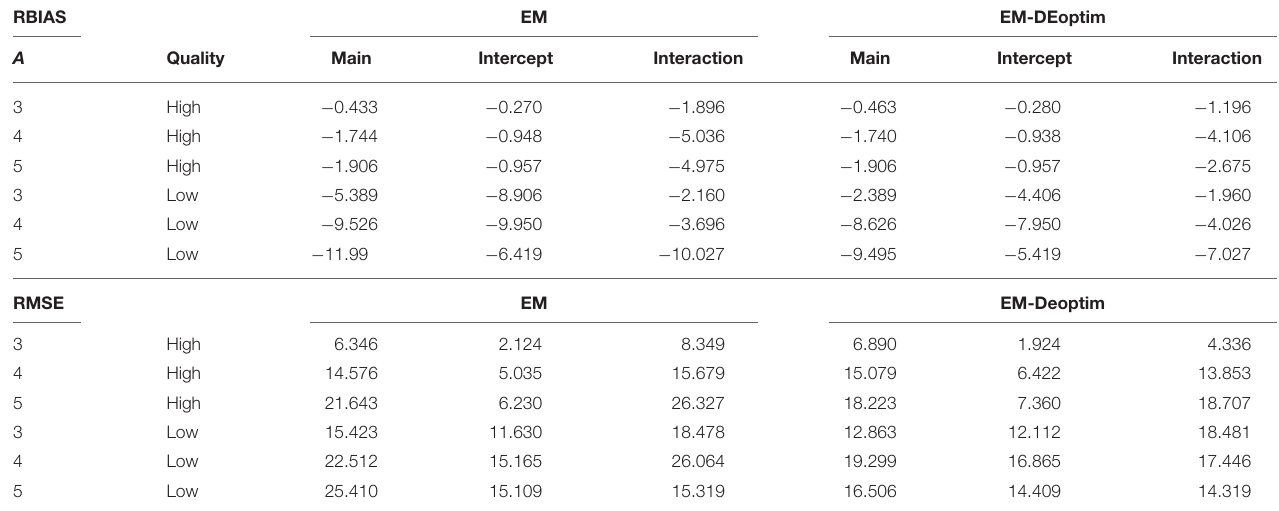
TABLE 4 | Item parameter estimates of the simulation study.